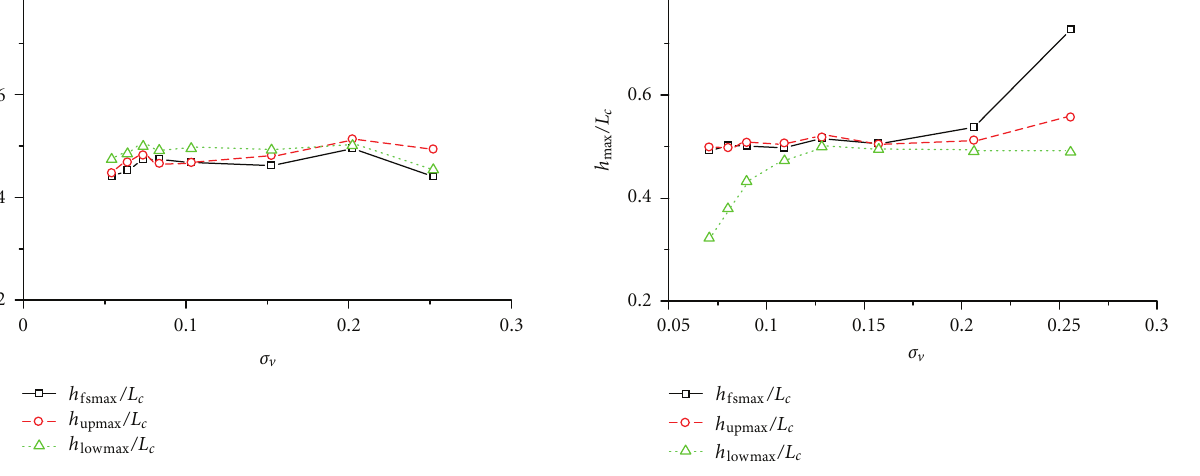
Figure 14: Positions located in the maximal level of the free surface and the maximal width of the cavity surface at di ff erent σ v , h/H = 0 . 50.